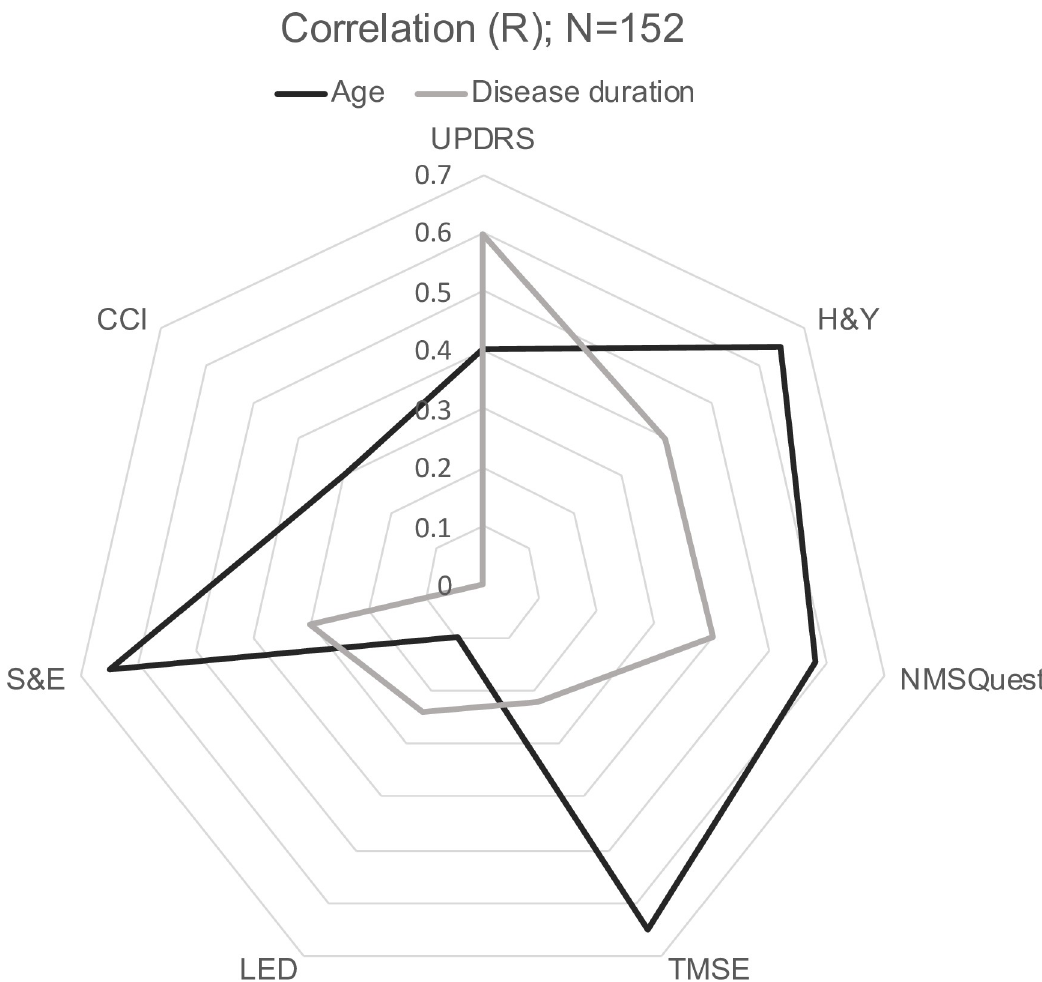
Fig 2. Radar graph of absolute correlations between age, disease duration and disease variables. UPDRS, Unified Parkinson’s Disease Rating Scale; H&Y, Hoehn & Yahr; NMSQuest, Non-Motor Symptoms Questionnaire; TMSE, Thai Mental State Examination; LED, levodopa equivalent dose; S&E-ADL, Schwab and England Activities of Daily Living; CCI, Charlson Cormorbidity